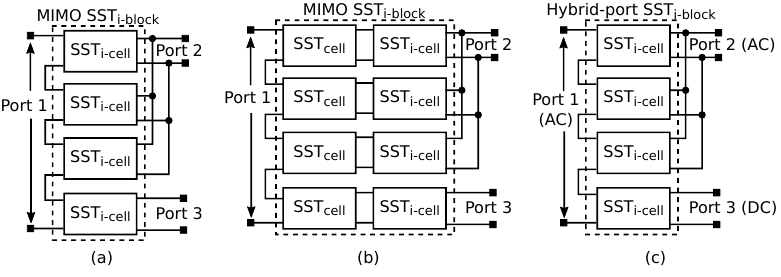
Figure 11. Formation of MIMO SST i-block [58]: ( a ) MIMO: three port SST i-block using SST i-cell , ( b ) MIMO: three port SST using two stage SST cell , ( c ) MIMO: hybrid-port SST i-block . 4. Classification of SSTs: